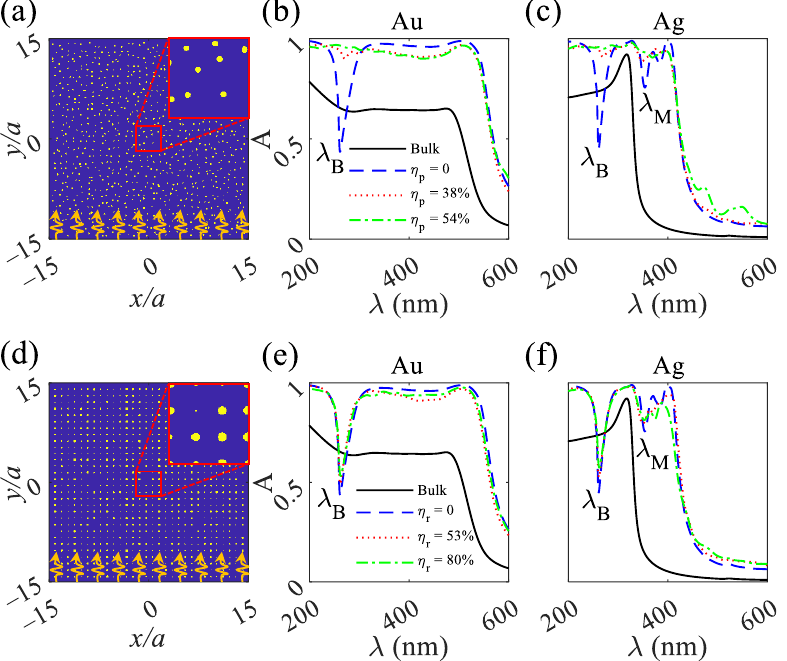
Figure 1. ( a ) Schematic of 2D MPHC absorbers consist of 30 × 30 cylindrical metallic rods in air at η p = 38%. ( b , c ) show absorption spectra for Au and Ag, respectively, under η p = 0, 38, and 54%. ( d ) Schematic of 2D MPHC absorbers consist of 30 × 30 cylindrical metallic rods in air at η r = 53%. ( e , f ) show absorption spectra for Au and Ag, respectively, under η r = 0, 53, and 80%. The insets in ( a , d ) show the magnification of 4 × 4 cylindrical rods in air. The yellow color shows the cylindrical rods, either Au or Ag, and the blue color shows air. TE polarized plane waves are depicted in an orange color and located at the bottom of ( a , d ) and they propagate from − y to y directions and recorded at the top of the structures. λ B and λ M stand for Bragg and Mie wavelengths, respectively. Bulk silver under the TE polarized plane wave illumination reveals an absorption of approximately 0.73 over 200 < λ < 280 nm that is due to the higher imaginary permittivity (Figure 2b; dot-dashed red curve). An absorption peak of 0.9 at λ = 300 nm is due to the positive real permittivity peak at the wavelength, which suppresses the reflection (Figure 2b; dotted blue curve). At λ > 300 nm, the absorption decreases sharply, owing to the lower imaginary permittivity and higher negative real permittivity, that results in increasing the reflection. Illuminating the plane wave upon the 2D MPHC containing Ag components at η r = η p = 0% (no radius and position disorderings) reveals absorption spectra with two dips. The first dip at λ B = 260 nm is a Bragg wavelength that shows the reflection, and the other occurs at λ M = 350 nm owing to Mie scattering. By increasing the position disordering from η p = 0% to η p = 54%, the Bragg and Mie dips disappear, resulting in a broad bandwidth with an absorption amplitude A > 90%. In contrast to the position disordering, by increasing the radius disordering from η r = 0% to η r = 80%, the absorption spectra remain unchanged due to the preserving of lattice constant and propagation